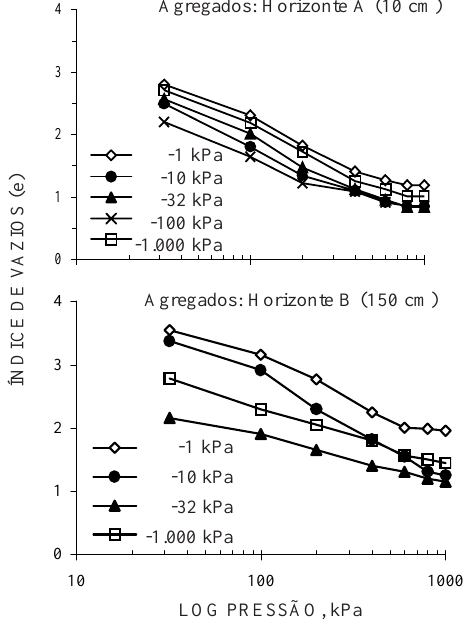
Figura 3. Evolução do índice de vazios (e) dos agre- gados dos horizontes A e B do Latossolo Ama- relo, considerando a pressão mecânica (kPa) aplicada para níveis de umidade corresponden- tes aos potenciais matriciais de -1, -10, -32, -100 e -1.000